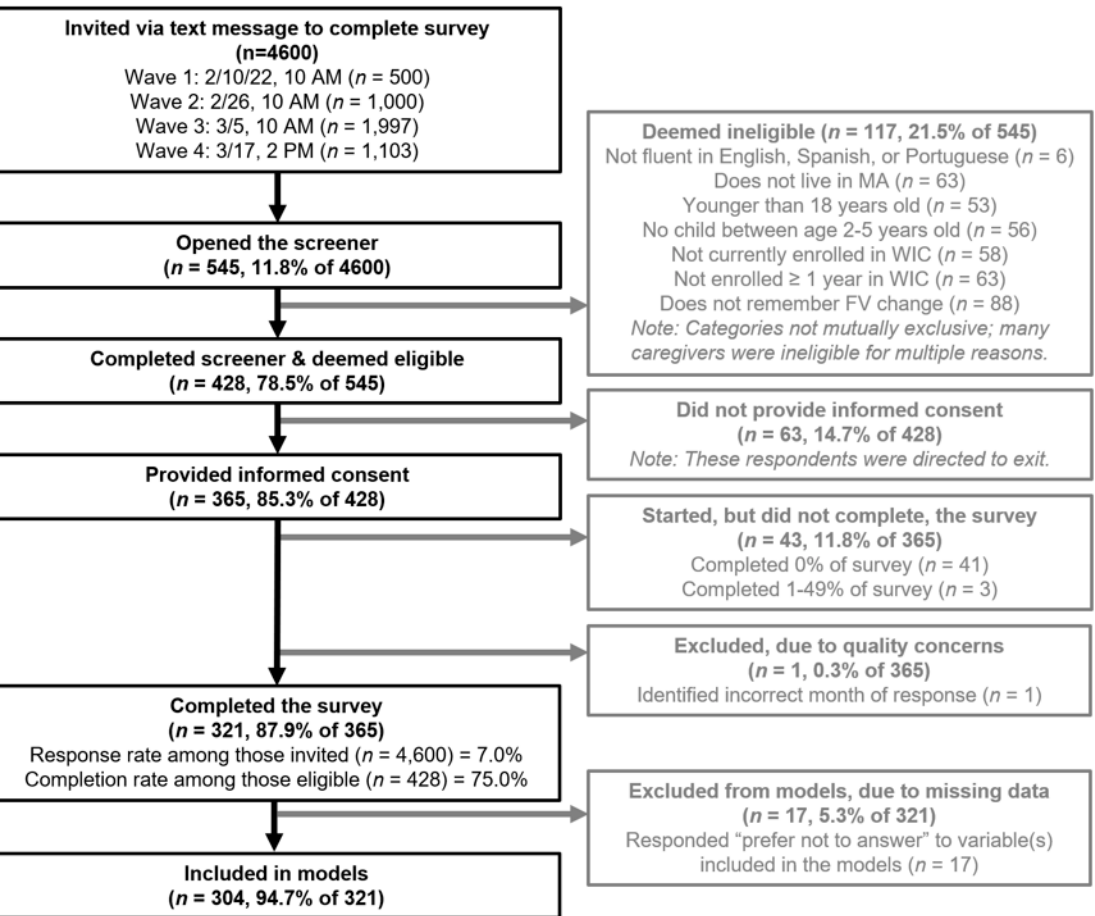
Figure 1. Participant Flow Diagram.